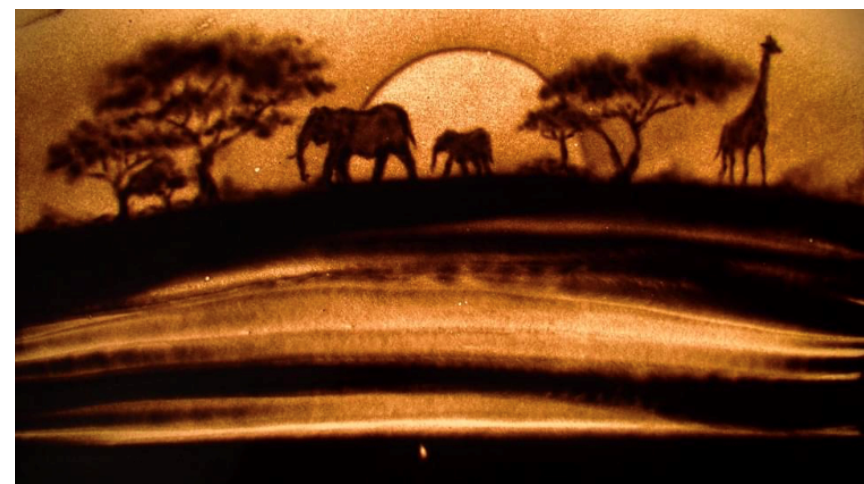
Figure 2. Sand Performance by JinLee, video screenshot, reproduced courtesy of